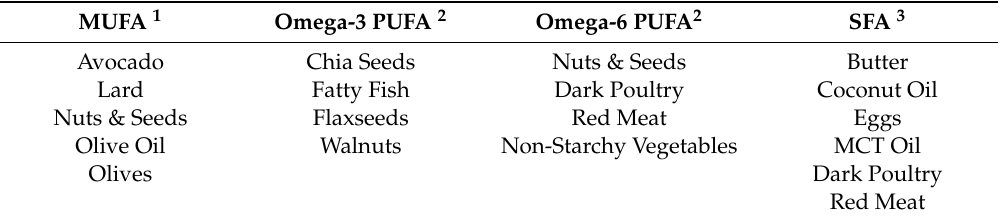
Table 2. Favorable ketogenic diet fatty acid